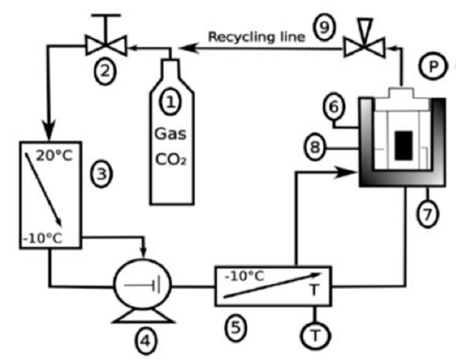
Figure 9. Schematic diagram of the supercritical equipment provided by Separex.